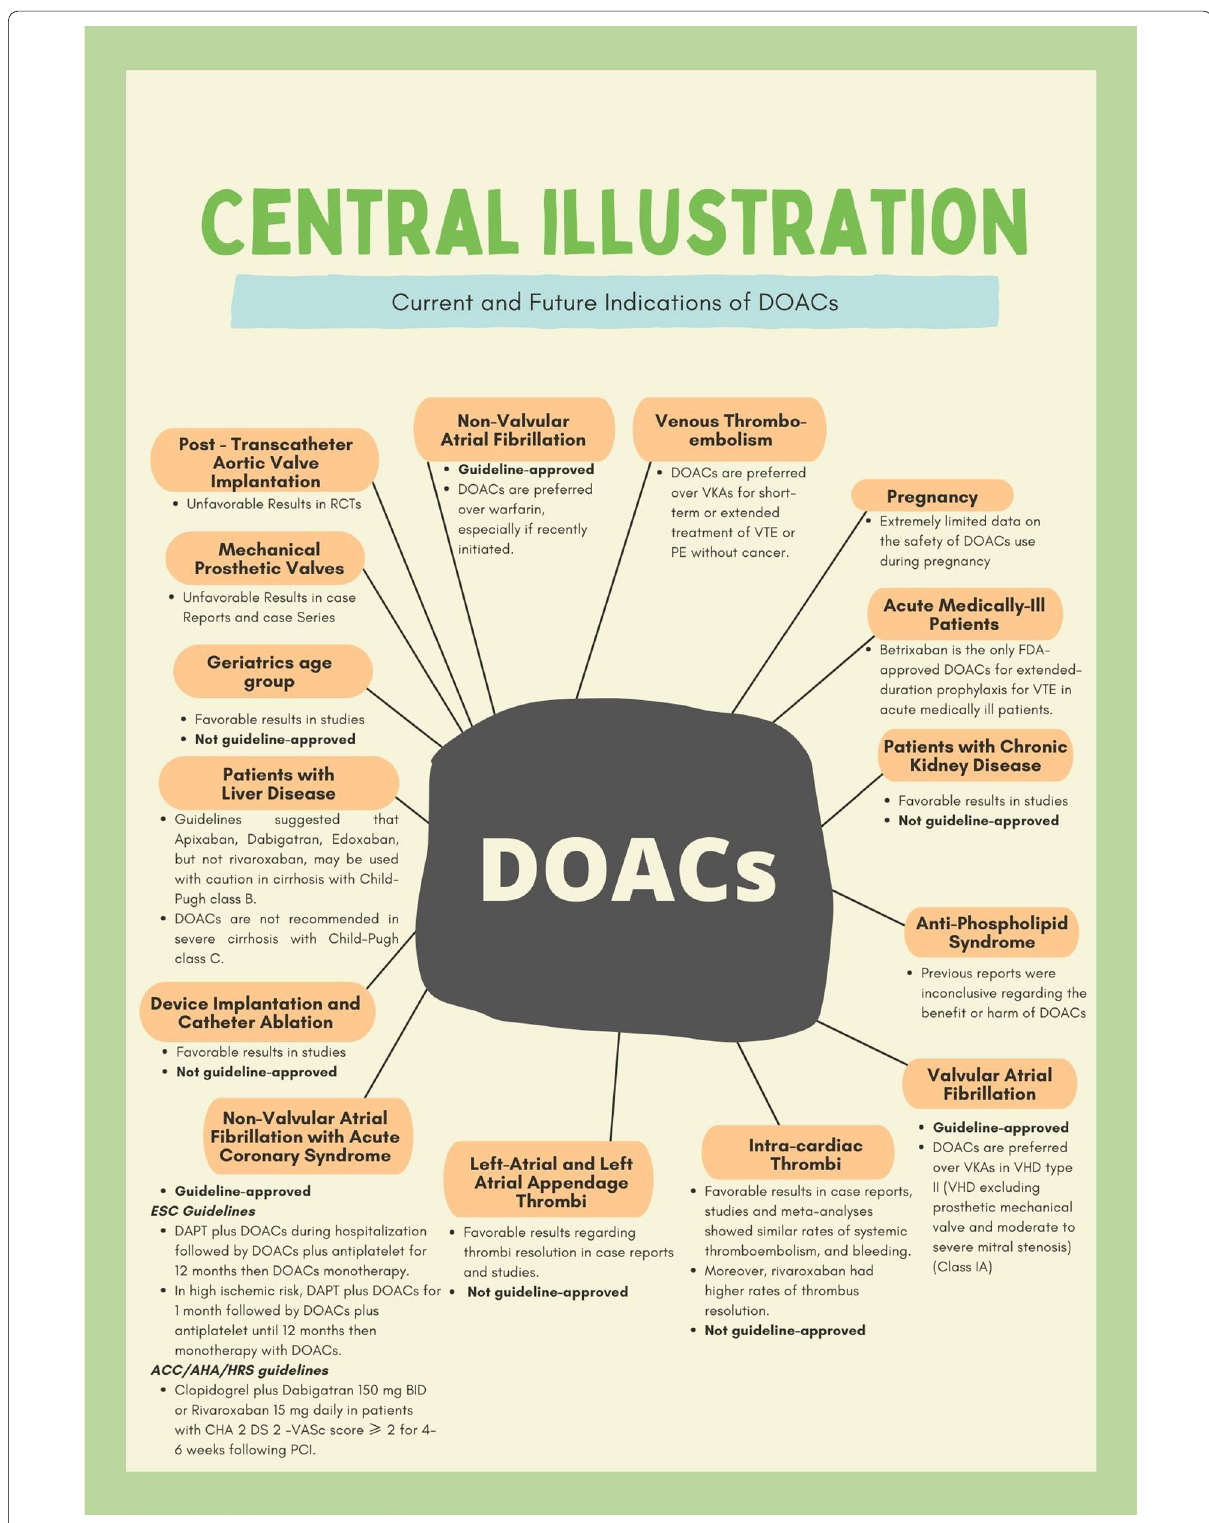
Fig. 4 Central illustration showing guideline recommended indications and proposed other indications of